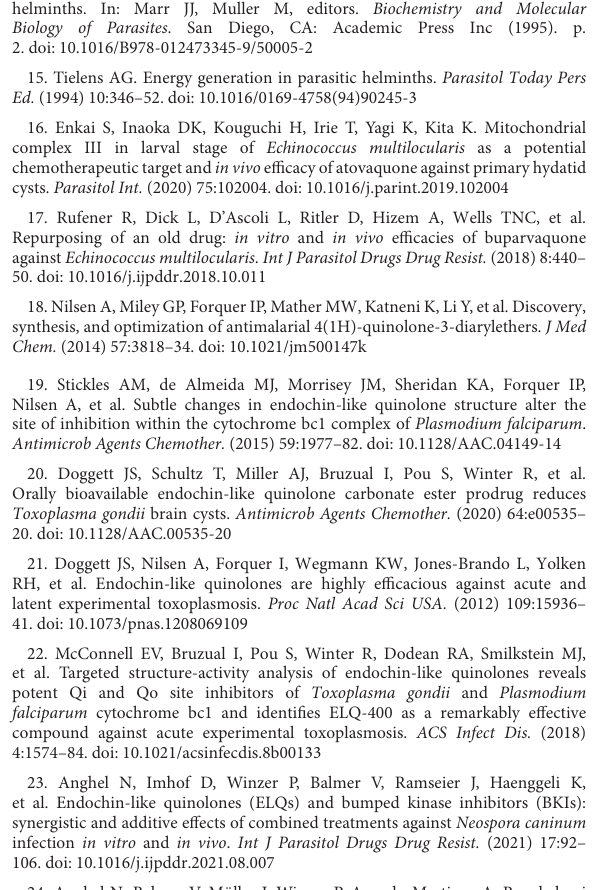
SUPPLEMENTARYFIGURE1 Alignment of cytochrome b sequences. Sequence alignment of cytochrome b between E. multilocularis (C6L2E3), T. gondii (S8EQL3), P. falciparum (Q02768), and H. sapiens (P00156; EgrG_900000100). Conserved sites are marked in gray (four out of five amino acids same) and in light gray (three out of five amino acids same). Dotted rectangles indicate the Qo site, solid lined rectangles the Qi